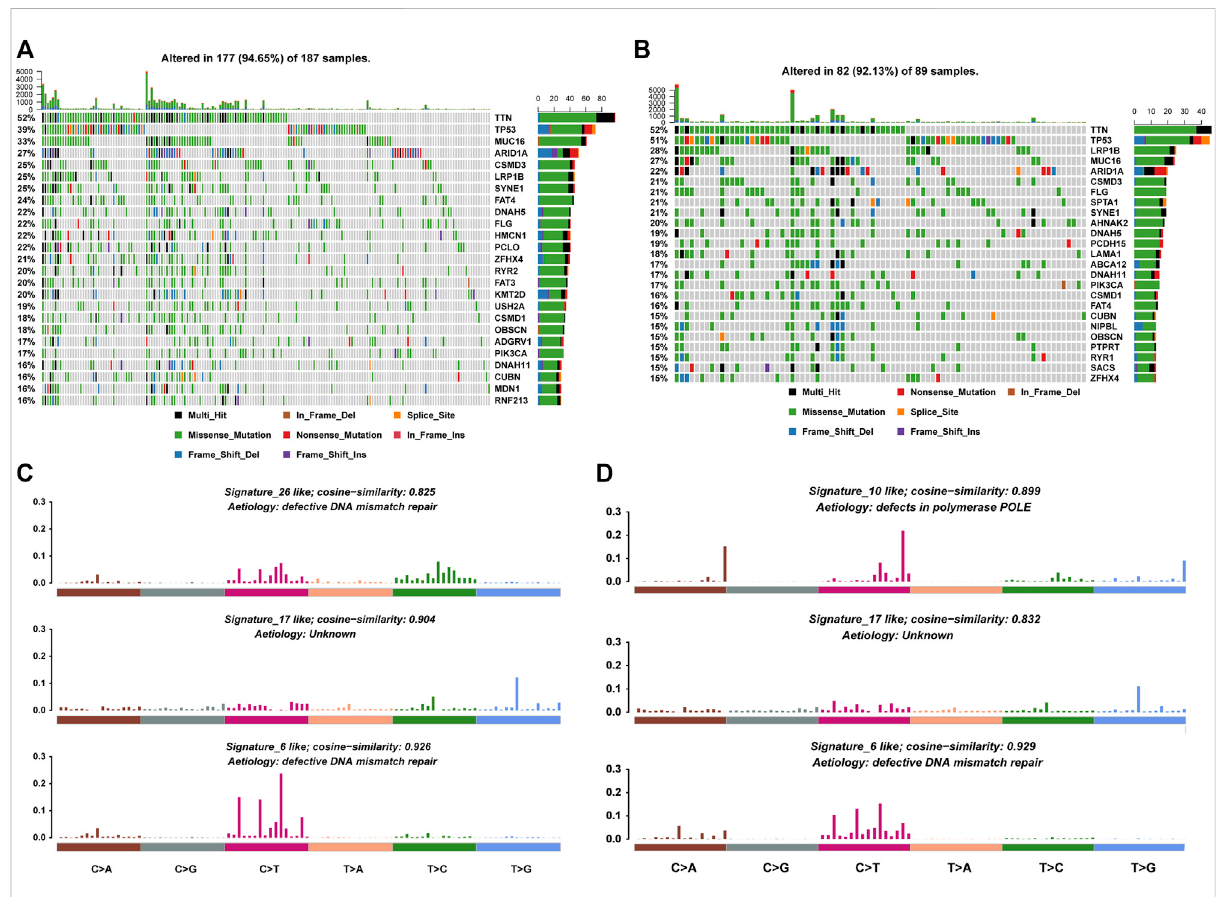
FIGURE 2 Mutationalpro fi lesofhighandlowlatitudes. (A,B) Topmutational25genesinhighandlowlatitudes. (C,D) Mutationalsignaturesinhighandlow